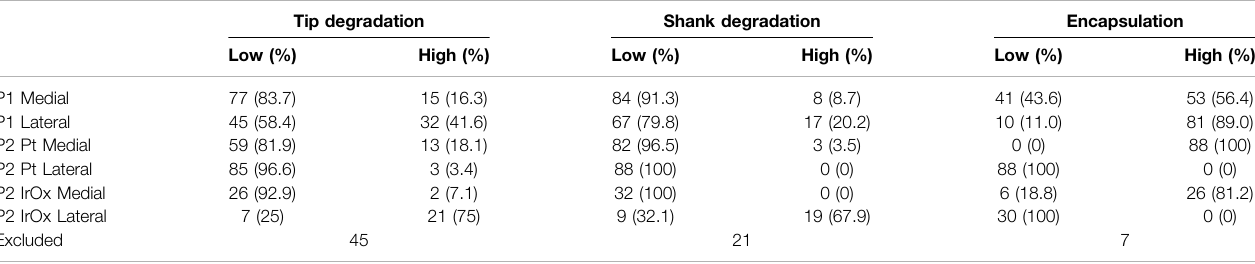
TABLE 2 | Number of electrically connected electrodes that were classi fi ed as undamaged/unencapsulated or damaged/encapsulated based on tip degradation, shank degradation, and tissue encapsulation. Tip degradation